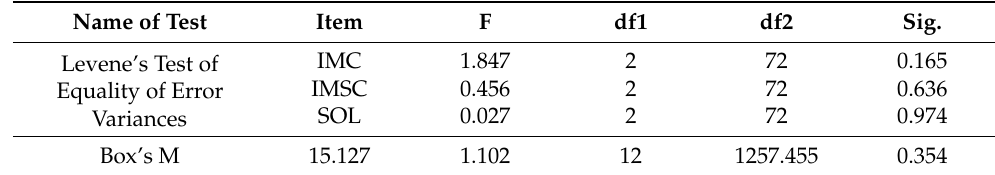
Table 9. Box’s Test of Equality of Covariance Matrices and Levene’s Test of Equality of Error